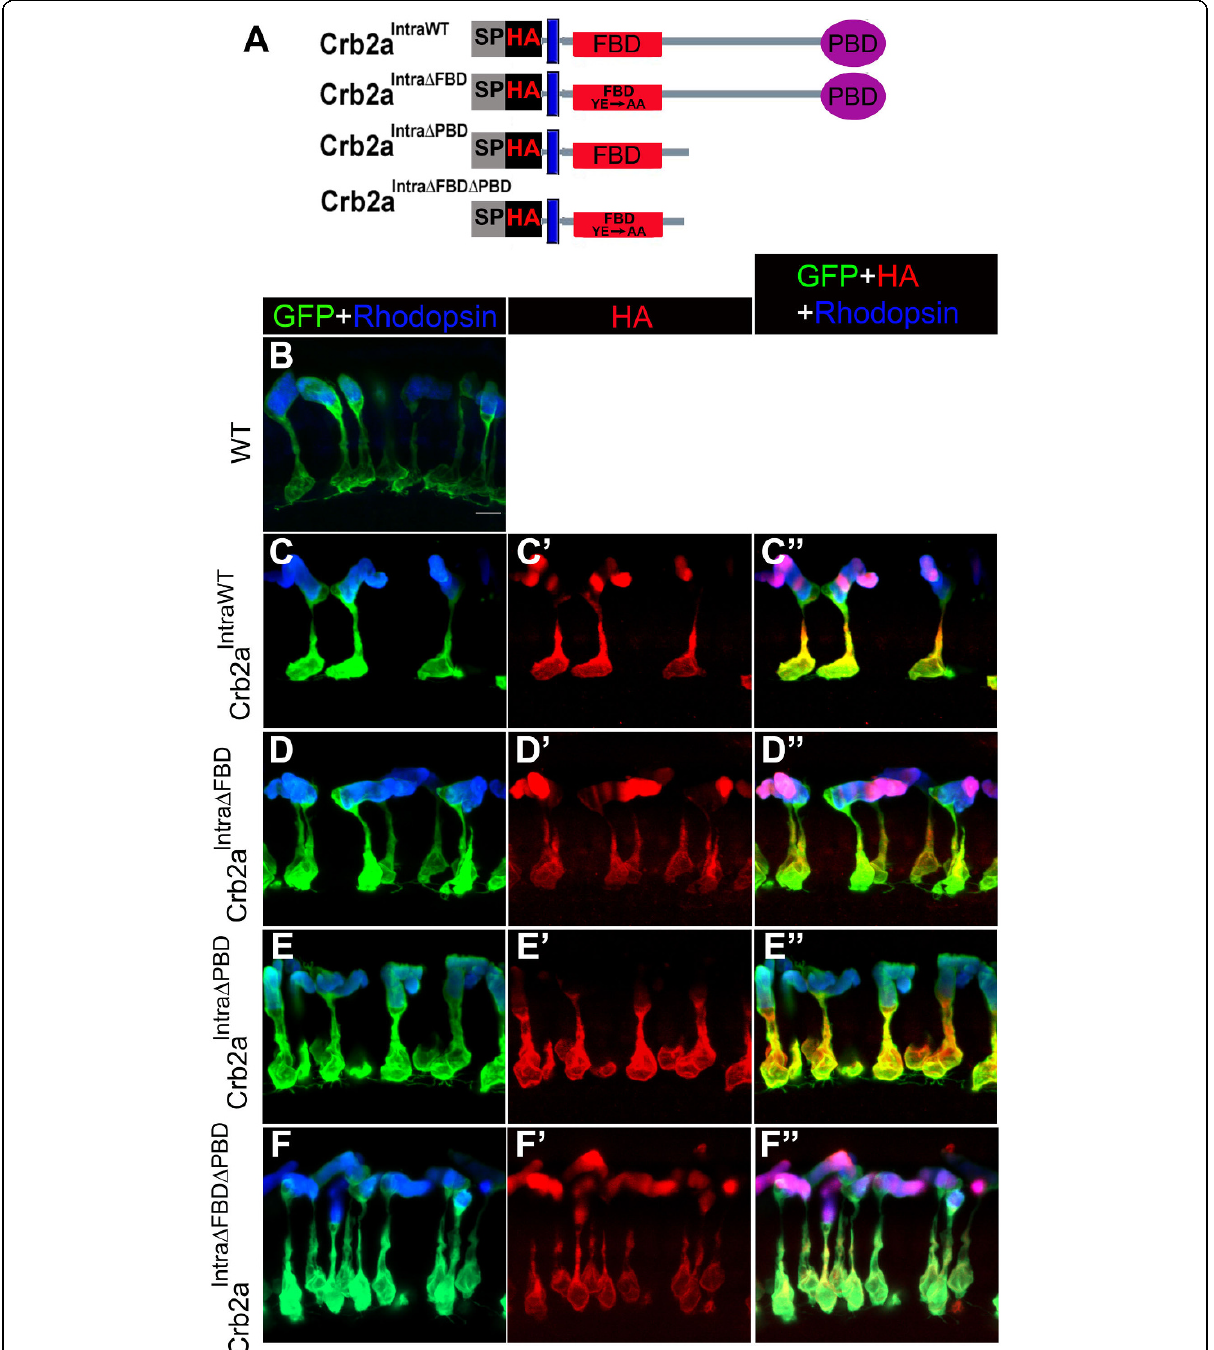
Figure 2 Localization of Crb2a constructs lacking the extracellular domain in rod photoreceptors and transgenic rod morphology . (A) Crb2a constructs lacking the extracellular domain. All constructs have a signal peptide (SP) followed by an HA tag. Crb2a IntraWT contains the transmembrane domain and intracellular sequence of Crb2a. Crb2a Intra Δ FBD bears two mutations (Y10A and E16A) within the FERM-binding domain (FBD). Crb2a Intra Δ PBD has the sequence following the FBD that contains the PDZ-binding domain (PBD) deleted. Crb2a Intra Δ FBD Δ PBD bears Y10A and E16A mutations within the FBD and the PBD the sequence following the FBD that contains the PDZ-binding domain (PBD) deleted. (B-F ” ) Confocal z-projections of 6 d rods labeled with GFP (green), Rhodopsin (blue) and anti-HA (red) antibodies. (B) Wild-type rods. (C-C ” ) Crb2a IntraWT transgenic rods. (D-D ” ) Crb2a Intra Δ FBD transgenic rods. (E-E ” ) Crb2a Intra Δ PBD transgenic rods. (F-F ” ) Crb2a Intra Δ FBD Δ PBD transgenic rods. Scale bar, 5 μ m (B-F ”